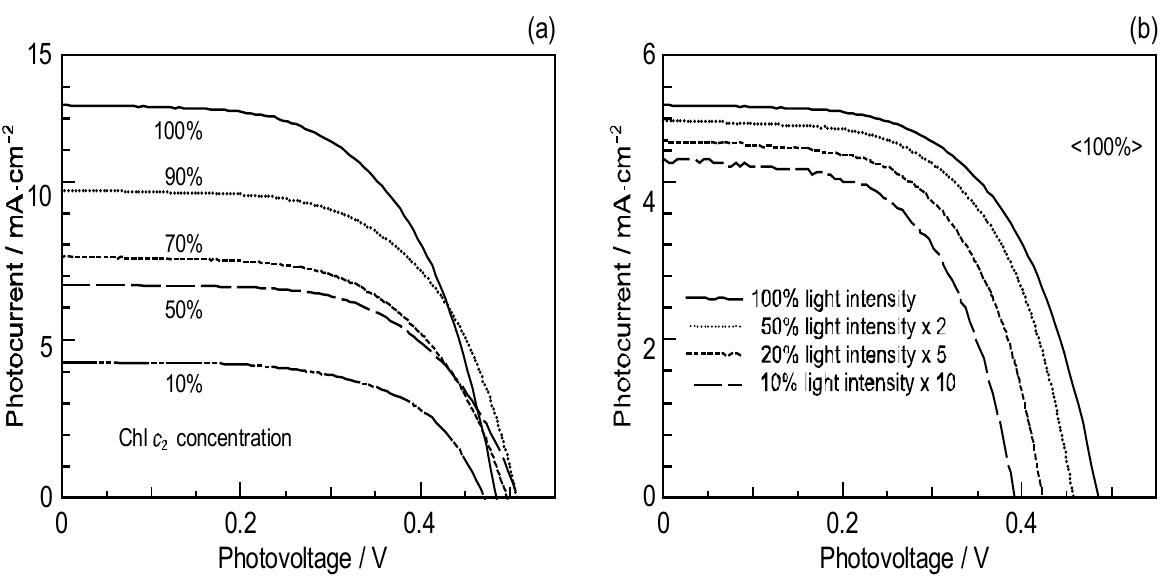
Figure 22. ( a ) Concentration dependence and ( b ) the light-intensity dependence of the I–V curves in Chl c -sensitized solar cell (reprinted from [10] with permission of 2